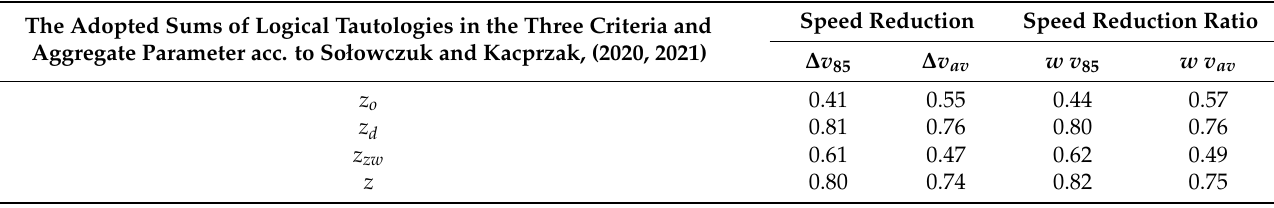
Table 5. Coefficients of correlation R between the sum of logical tautologies in the respective criteria or the aggregate parameter and the selected speed distribution parameters (transition zones in study area No. 3